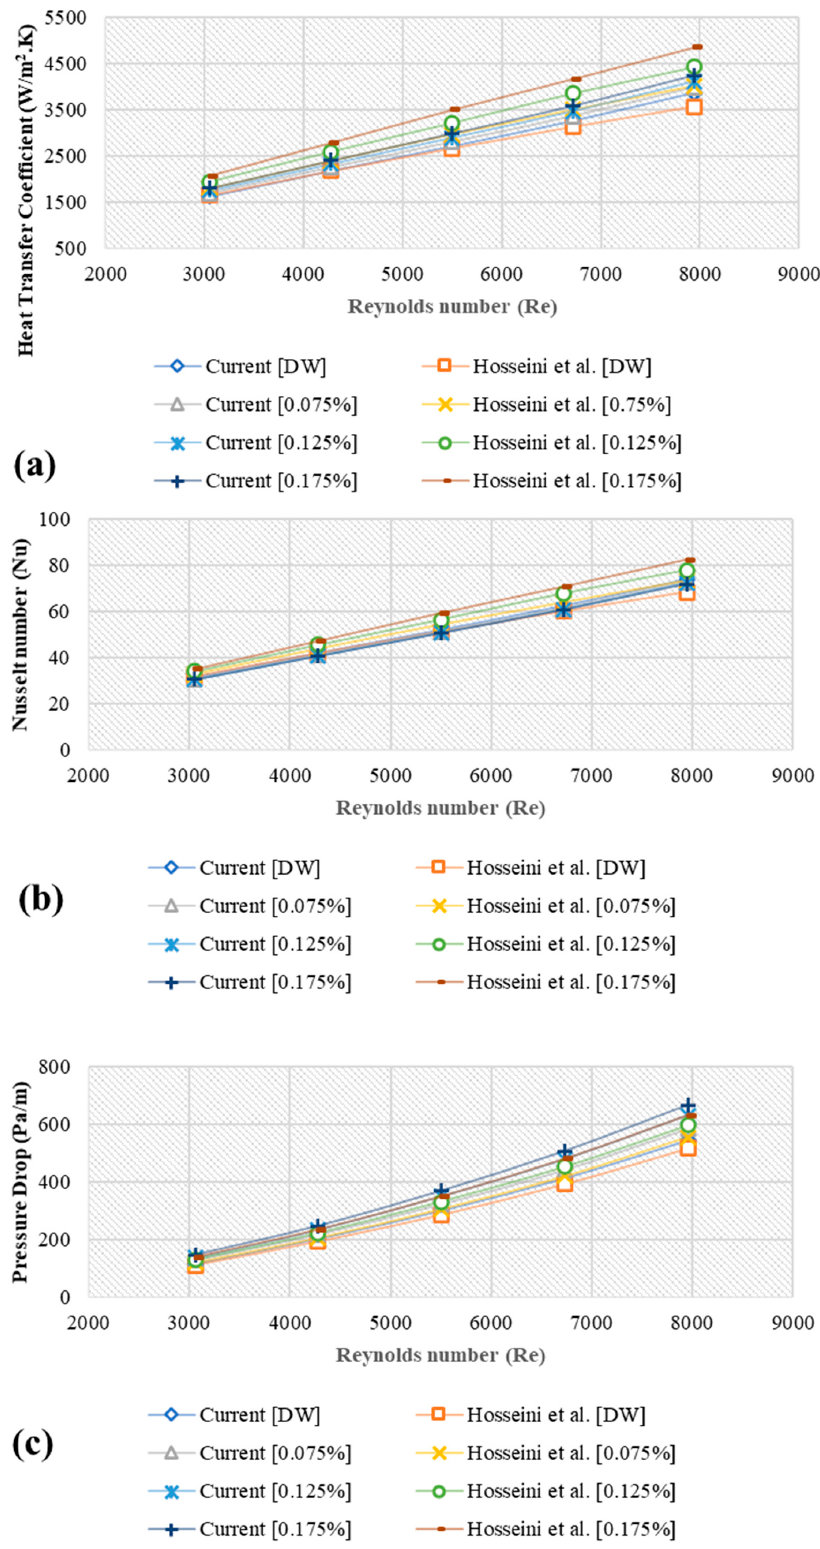
Figure 3. Comparison of the results of the current study with those of Hosseini et al. [12]; ( a ) Heat transfer coefficient, ( b ) Nusselt number, ( c ) Pressure loss.